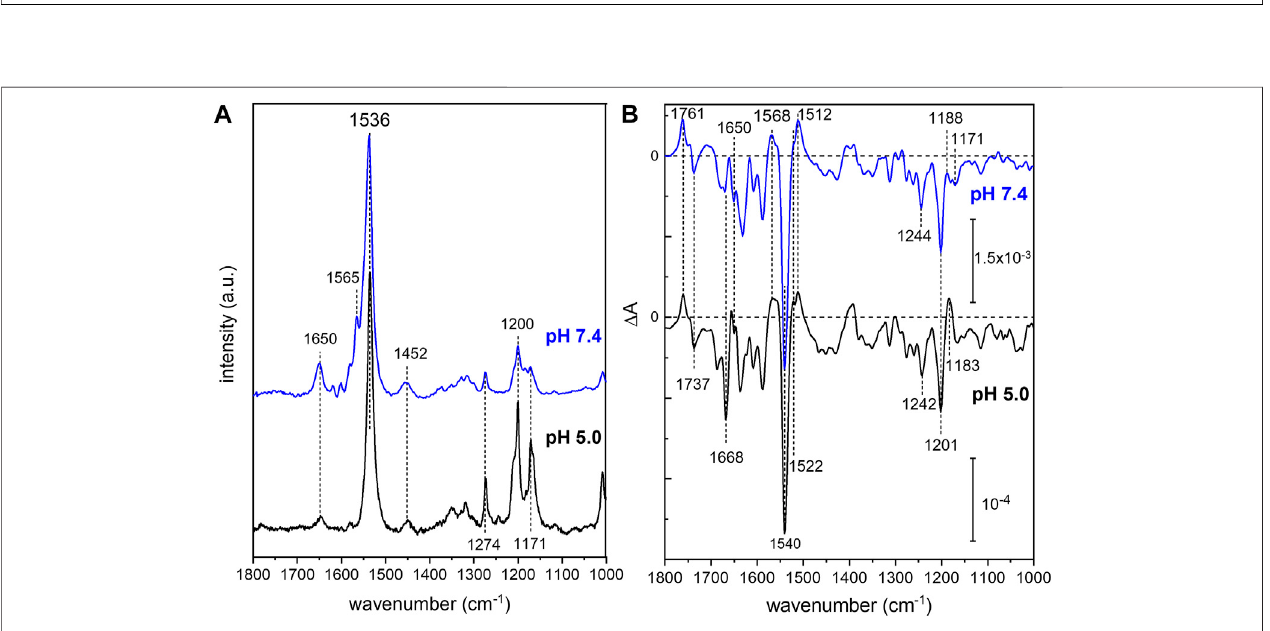
FIGURE 7 | Vibrational spectra of Um Rh1. Resonance Raman spectra (A) were recorded at 647 nm (pH 5) and 457 nm (pH 7.4). Light-induced FTIR difference spectra (B) have been obtained under continuous illumination with a green LED ( λ = 525 nm). Blue spectra correspond to pH 7.4 and black spectra to pH 5. The spectrum recorded at pH 7.4 has been scaled to match the signal size of the spectrum recorded at pH